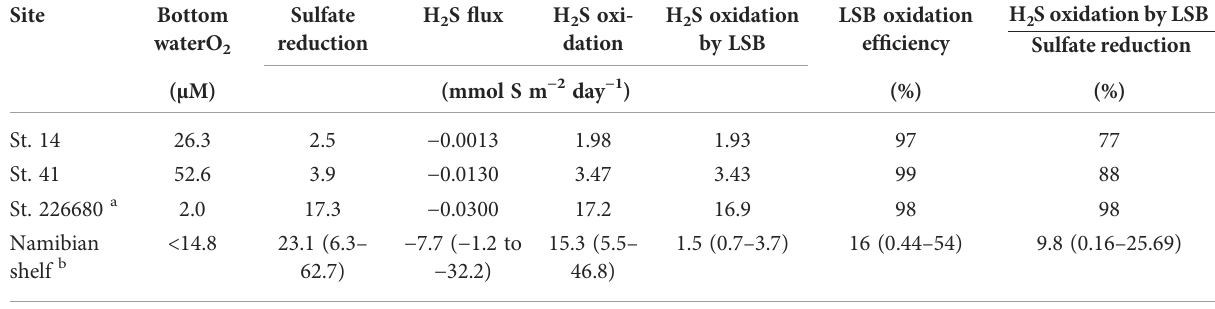
TABLE 2 Depth-integrated modeled rates of sulfate reduction, H 2 S oxidation, and the benthic H 2 S fl ux in sediments inhabited by LSB. Site